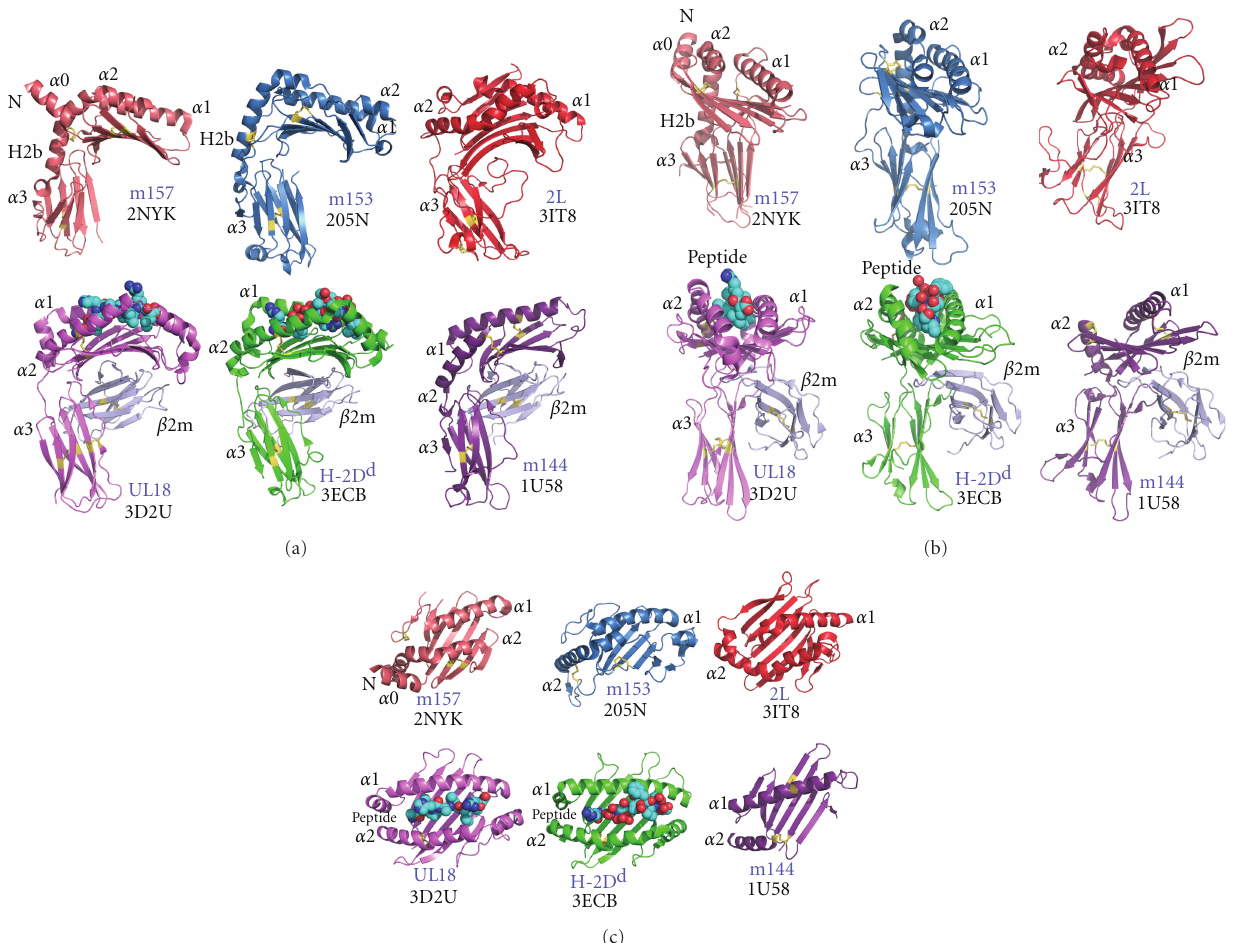
Figure 3: X-ray structures of m157 (2NYK) [64], m153 (205N) [74, 84], m144 (IU58), HCMV UL18 (3D2U) [75], Tanapox 2L protein (3IT8) [85], and H-2D d (3ECB) [86] reveal both shared and unique features. The disulfide bonds are in yellow. The α 1, α 2 and H2b helices and α 3 domain are labeled. Ribbon diagrams of the structures in (a), rotated 90 ◦ to the right in (b), reveal di ff erences in β 2m and peptide binding (a, b). The view from the top shows di ff erences in the peptide binding pocket (c). Illustrations were prepared from the superposed structures of the molecules using PyMOL